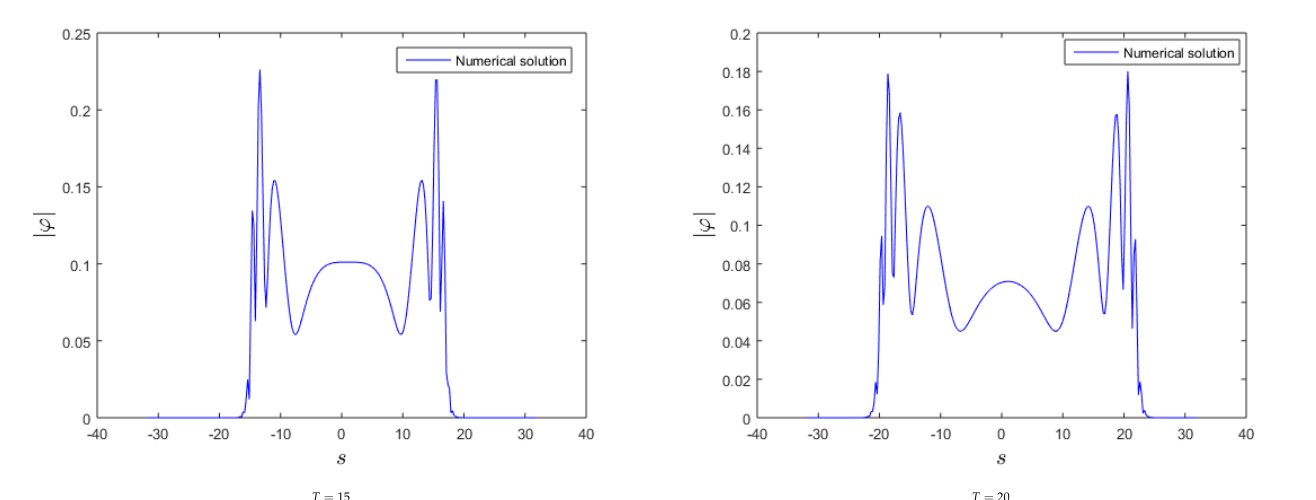
Figure 3. The profile of soliton wave at various T with M = 128 and ∆ τ = 0.01 for Test Problem 3.